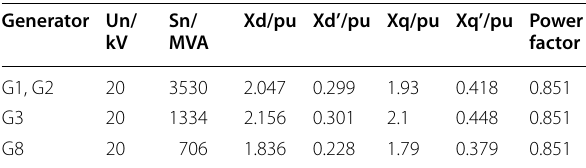
Table 2 Parameters of the generators